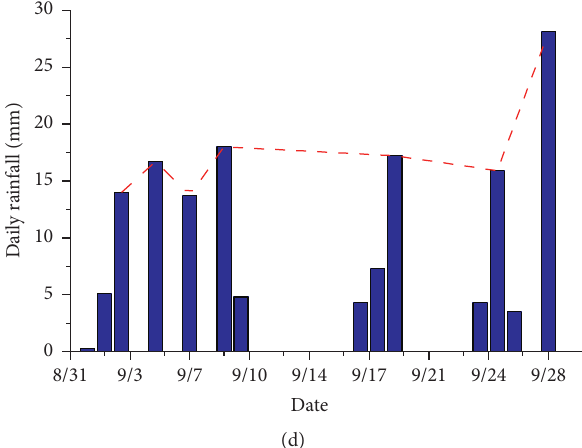
Figure 4: The daily distribuition (a) from May to October; (b) in July; (c) in August; (d) in September in Mengla county.